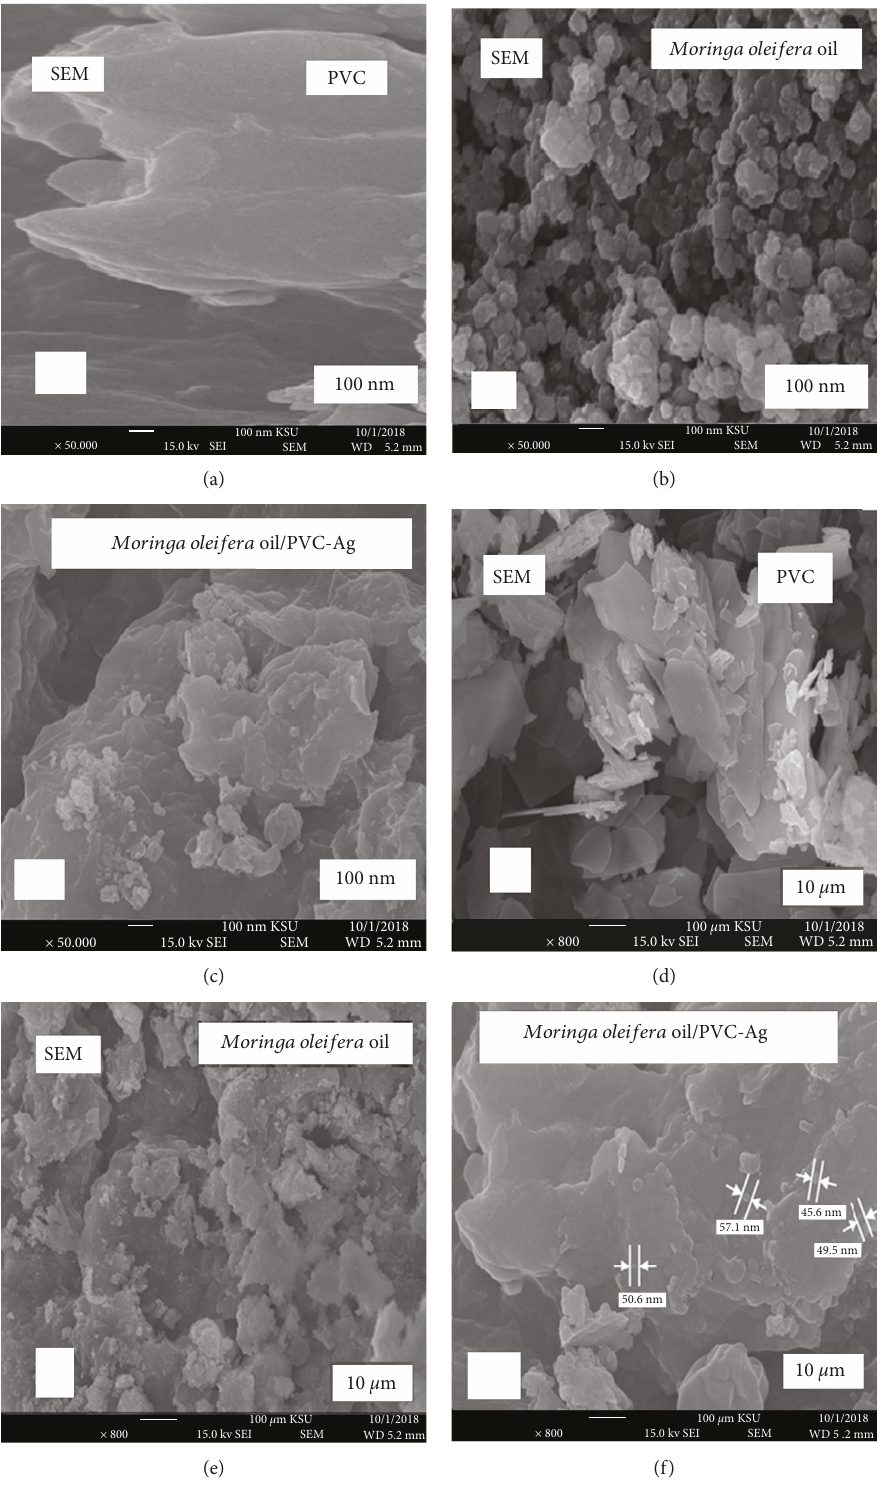
Figure 2: SEM images of (a and d) plain PVC, (b and e) Moringa oleifera oil, and (c and f) Moringa oleifera oil/PVC-AgNPs at 50000x and 800x magni fi